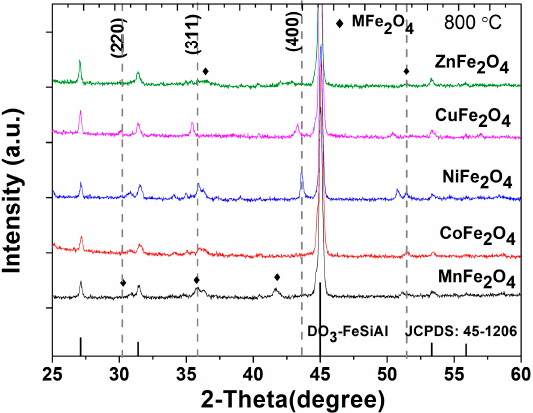
Figure 3. XRD pattern of flaky FeSiAl composites coated with MFe 2 O 4 (M = Mn, Co, Ni, Cu, Zn) ferrites annealing at 800 °C.